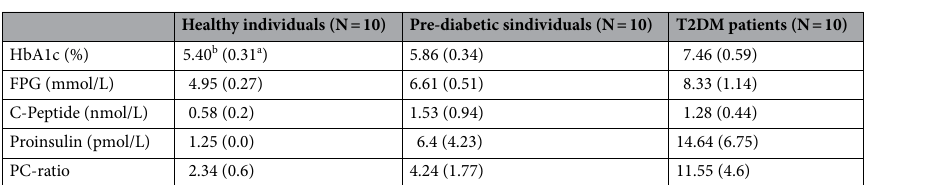
Table 1. Fasting screening data for the study population (N = 30). FPG fasting plasma glucose, PC-ratio proinsulin/C-peptide ratio. a Standard deviation. b